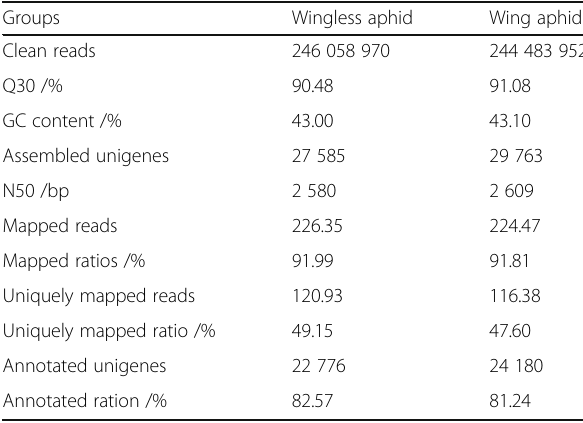
Table 1 Summary of transcriptome data of wingless and wing cotton